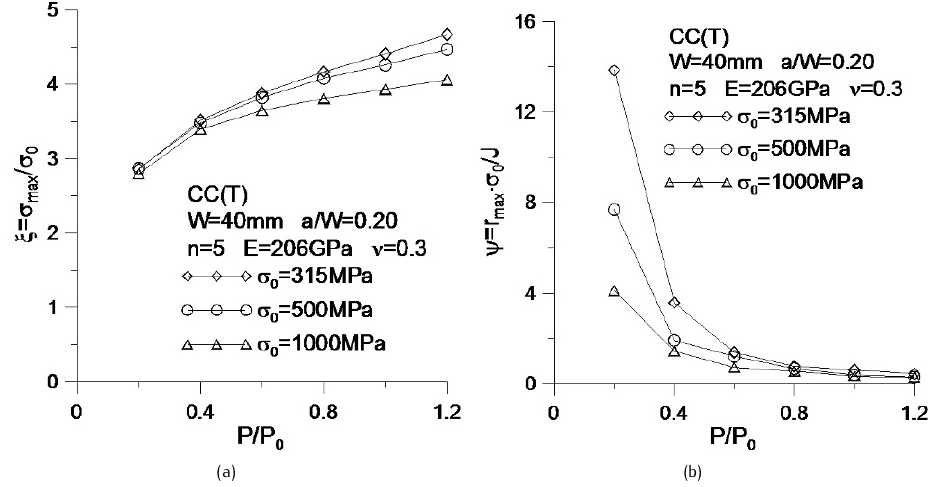
Figure 9. The influence of the yield stress on maximum opening stress value σ (b) for CC(T) specimen – a/W = 0 . 20 , n = 5